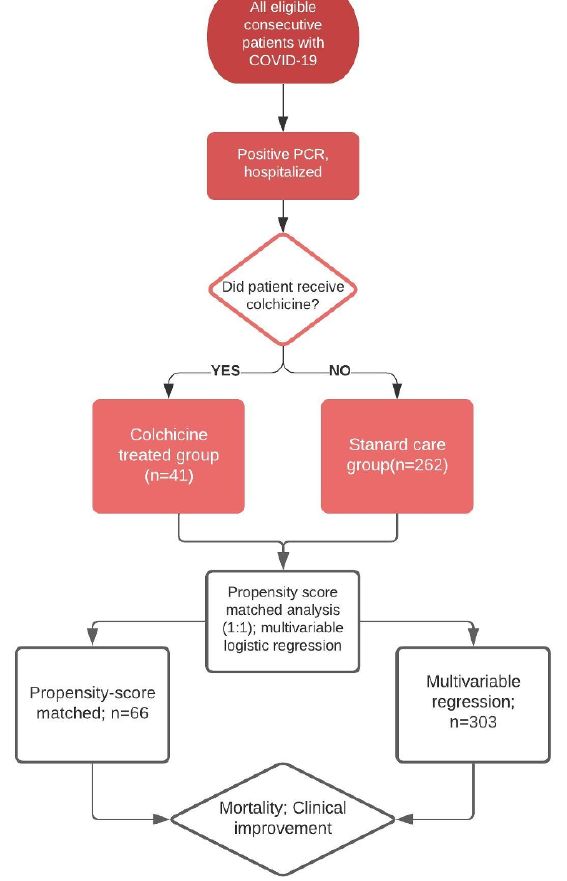
Figure 1. Overview of study data selection and analysis.